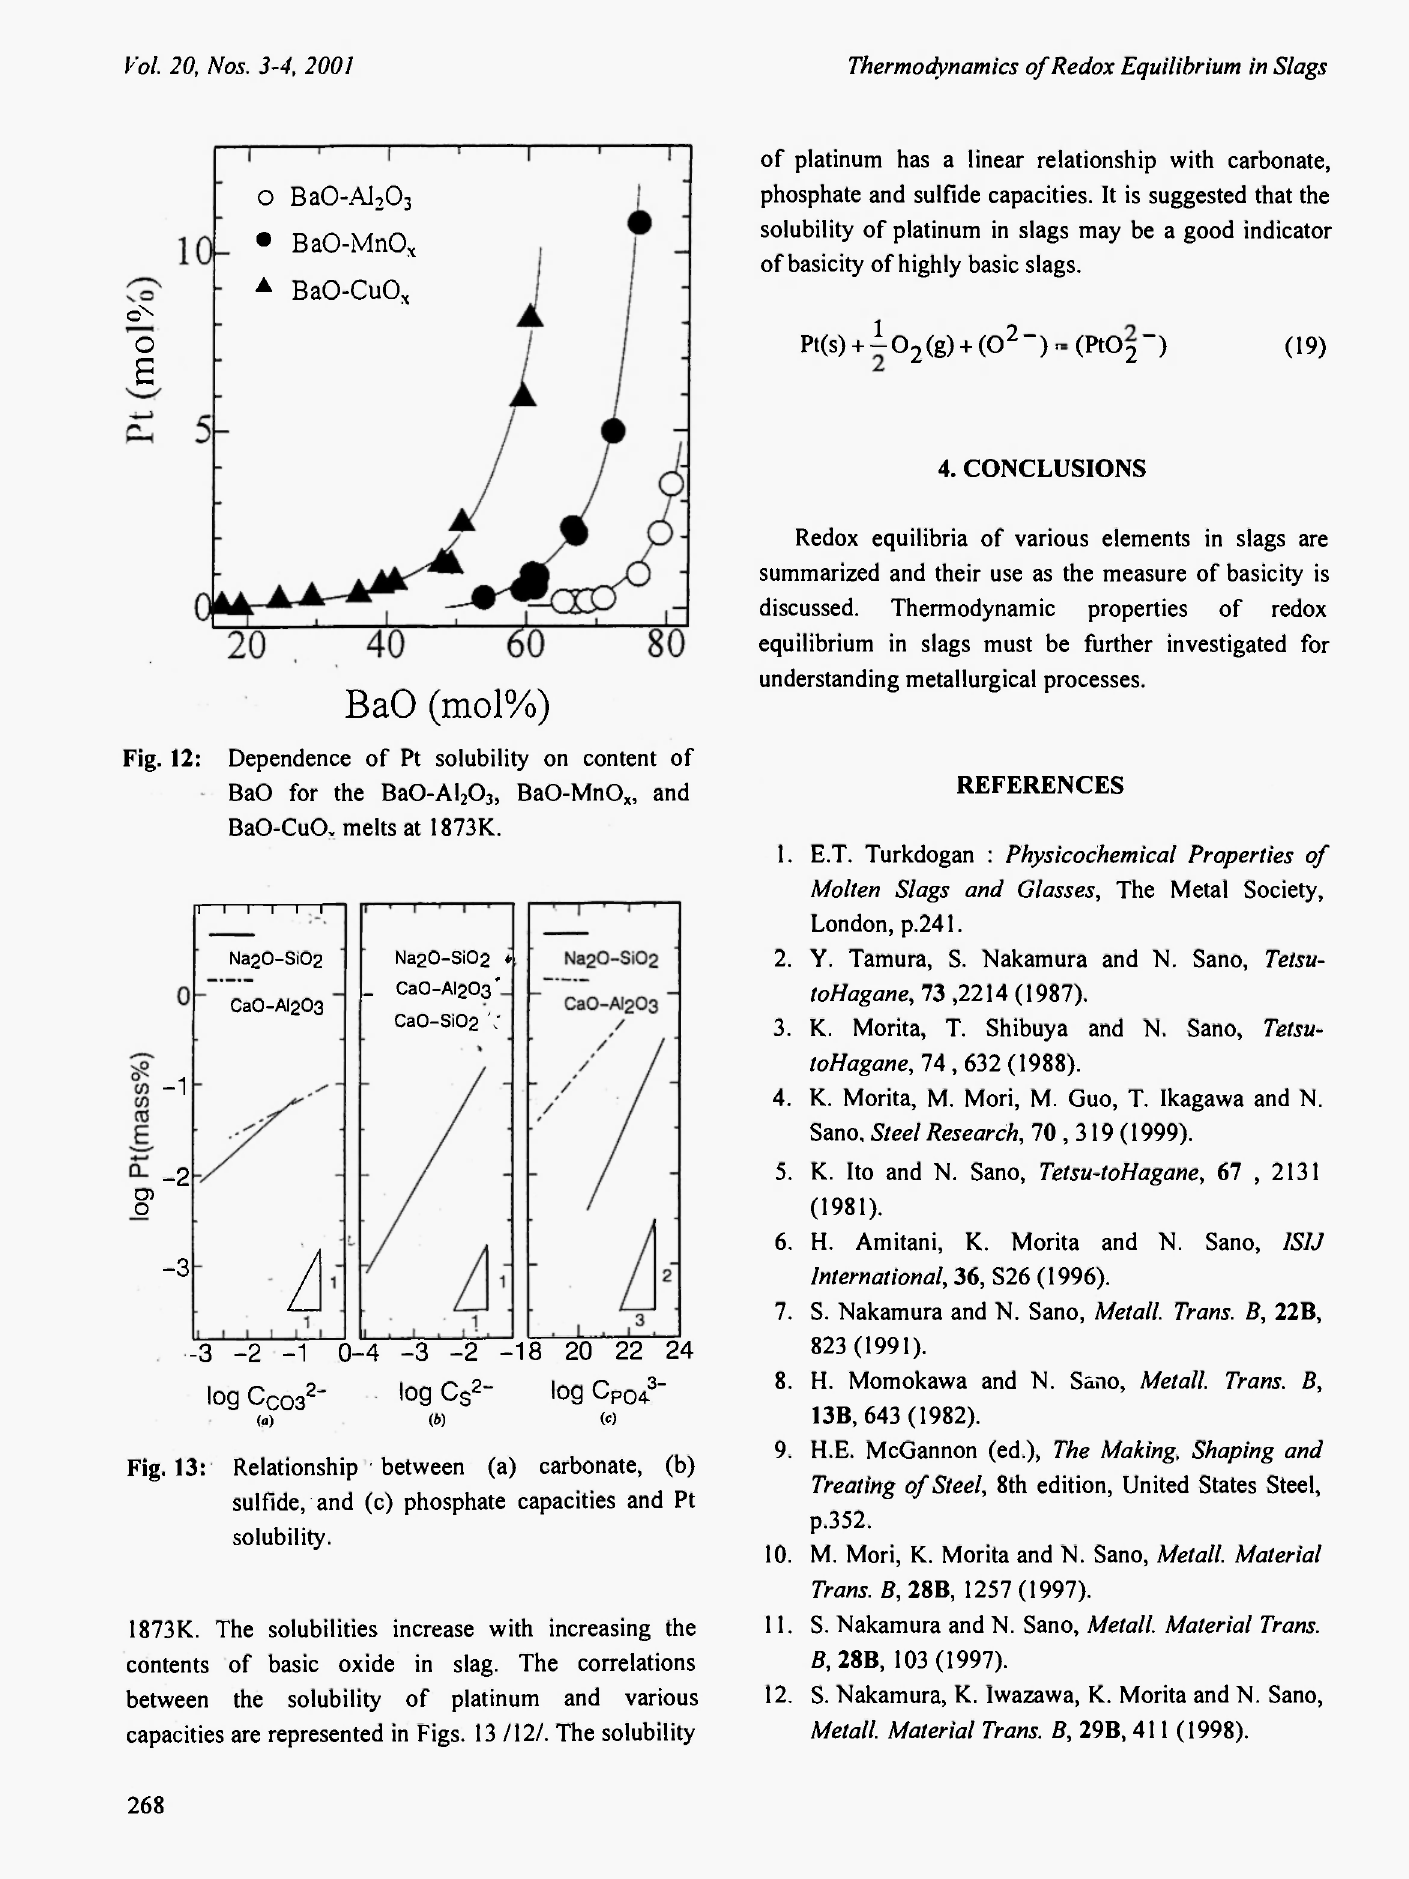
Fig. 13: Relationship between (a) carbonate, (b) sulfide, and (c) phosphate capacities and Pt